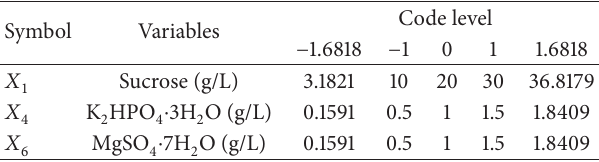
Table 3: Factors and levels of central composite design for carbon sources and inorganic salts.